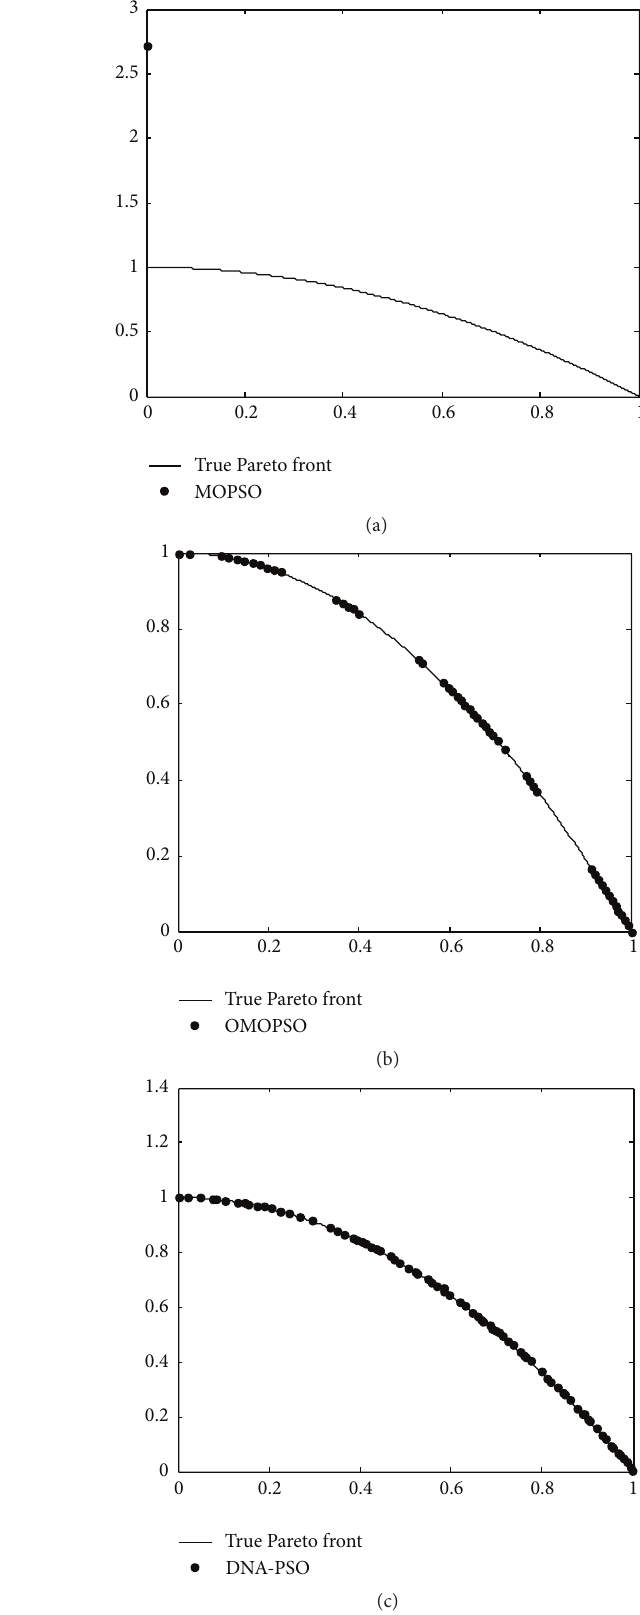
Figure 6: Pareto fronts obtained in test problem ZDT1. Figure 7: Pareto fronts obtained in test problem